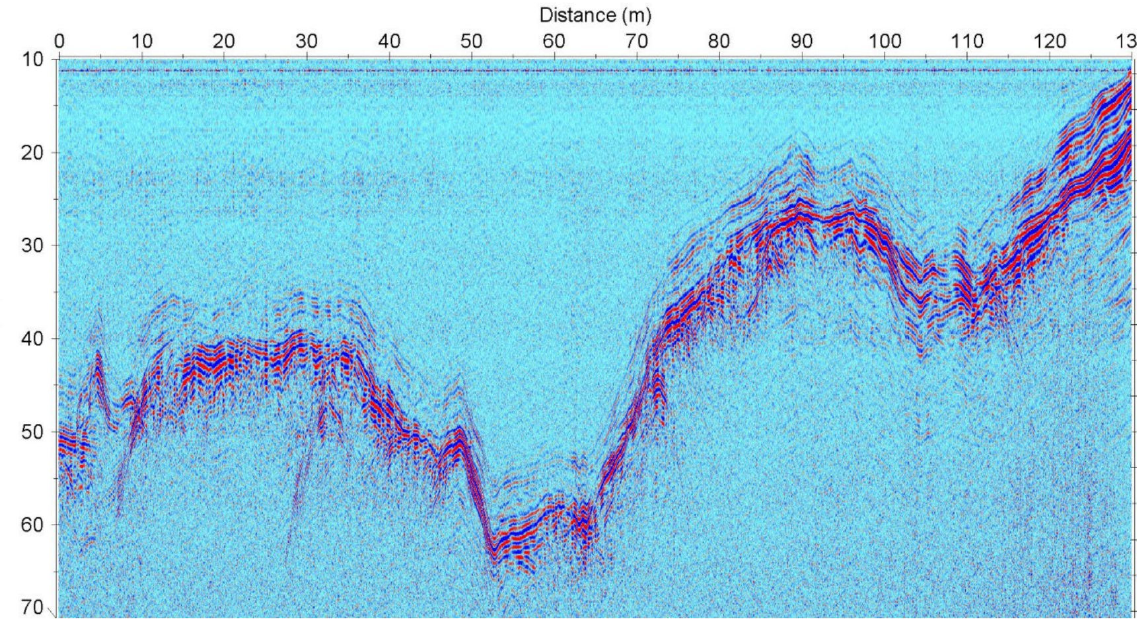
Figure 6. Calibration of the snow velocity from pickings of ground-based GPR survey (blue line) and manually measured points (in red) along the transect #1. The best-fitting is obtained for velocity = 0.26 m/ns.